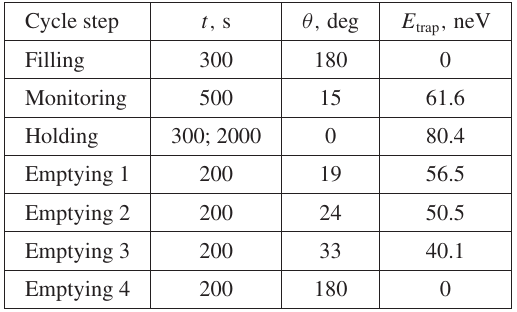
Table 1. Parameters of the measuring procedure with monitoring but without the absorber. E trap is the gravitational trap barrier at the quoted trap rotation angle θ .